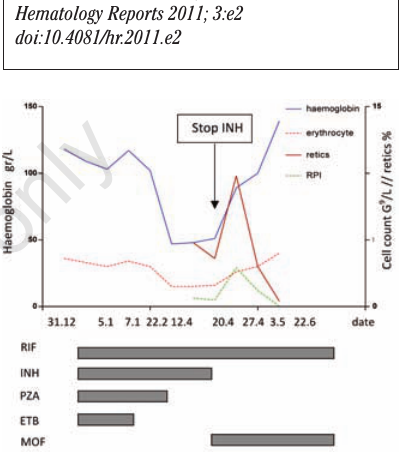
Figure 1. Blood values and treatment duration. RIF, rifampin; INH, isoniazid; PZA, pyrazi-